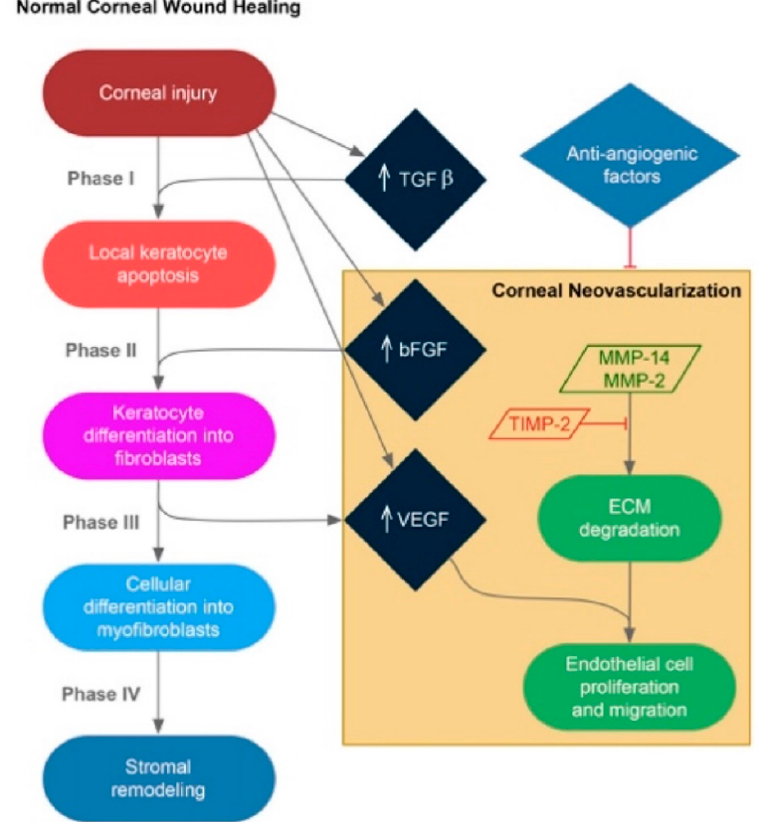
Figure 1. Corneal stromal wound healing. Stromal wound healing in the cornea is mediated by signaling of transforming growth factor-beta (TGF- β ), matrix metalloproteinases (MMPs), and a balance between pro-angiogenic and anti-angiogenic factors. In some cases, corneal neovascularization can